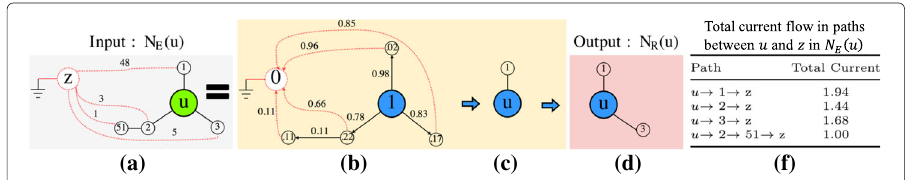
Fig. 3 Neighborhood refinement example. ( a ) Represents the expanded neighborhood of node u , N E ( u ) . The number on each red-dotted line refers to an edge conductance. ( b ) Indicates the nodes’ voltages (the numbers shown inside nodes) and currents flow through edges (reveal on the red-dotted lines) computations. ( c ) and ( d ) Indicate the refinement of node u by adding the neighbors: node 1 and 3 that maximizes the current flows from node u to node z to form the refined neighborhood of node u , N R ( u ) . ( f ) Refers to the computation of total current flows through each possible path between nodes u and z